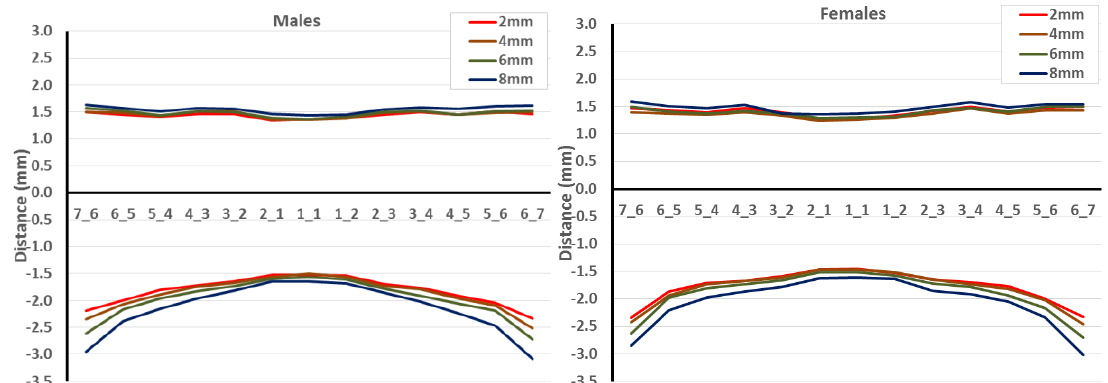
Figure 2: The height of the buccal cortical bone thickness in the maxilla and mandible for males and females at different sites from the alveolar